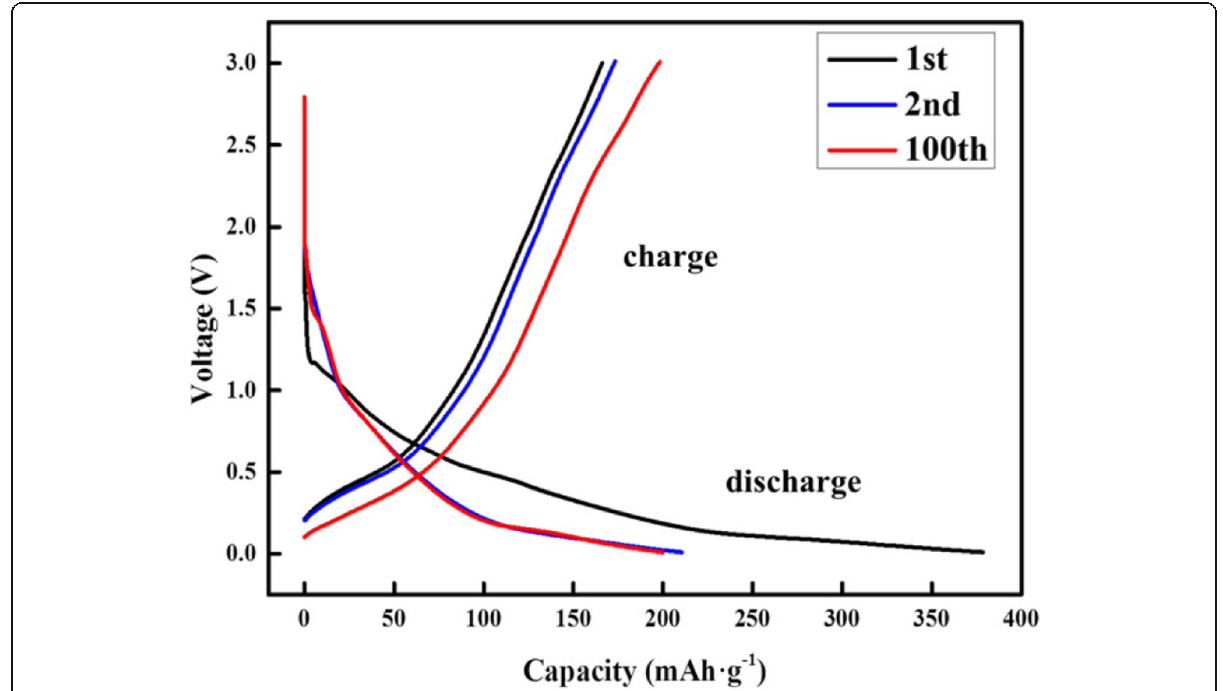
Fig. 5 The galvanostatic discharge – charge voltage profiles of hexabenzocoronene anode as a function of cycling numbers